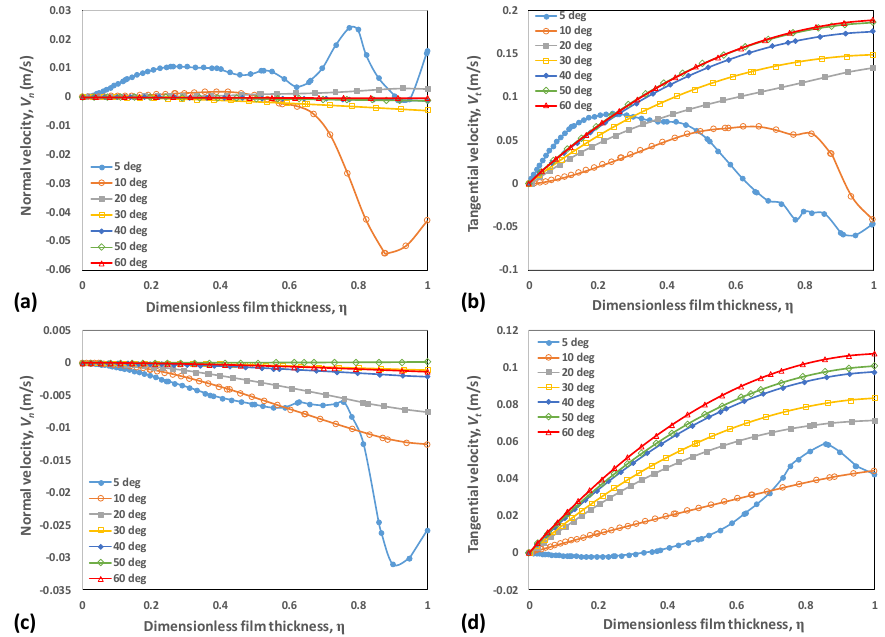
Figure 10. Velocity vector for Γ 1 / 2 = 0.05 kg / (m · s) and ( a ) C = 0.45 ( b ) C = 0.65 and ( c ) dimensionless film thickness η schematic.